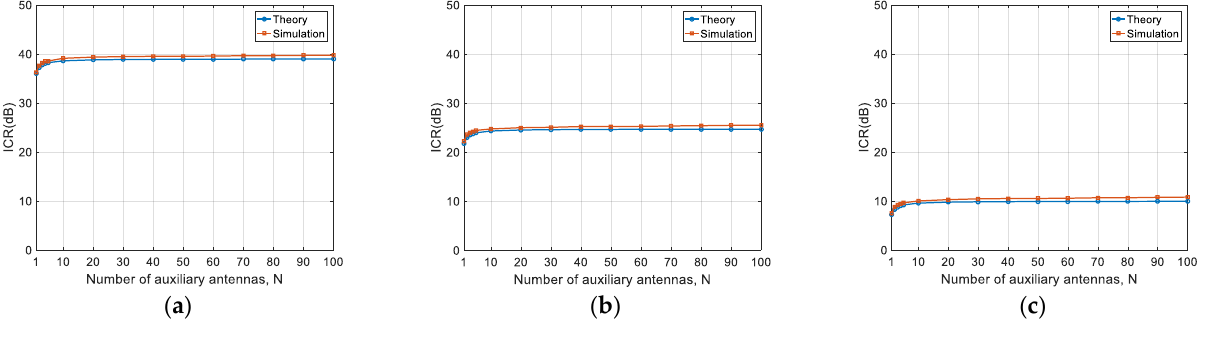
Figure 7. ICR versus the number of auxiliary antennas: ( a ) δ 2 = 1.27 × 10 − 4 rad 2 ; ( b ) δ 2 = 3.40 × 10 − 3 rad 2 ; ( c ) δ 2 = 1.07 × 10 − 1 rad 2